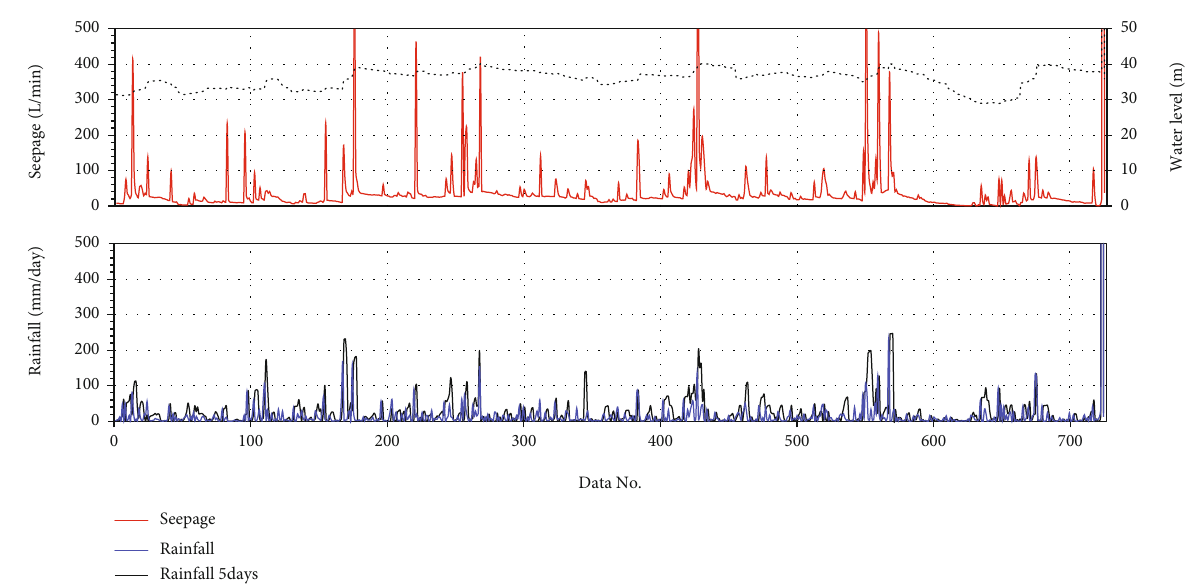
Figure 11: Seepage, rainfall, and water level for group